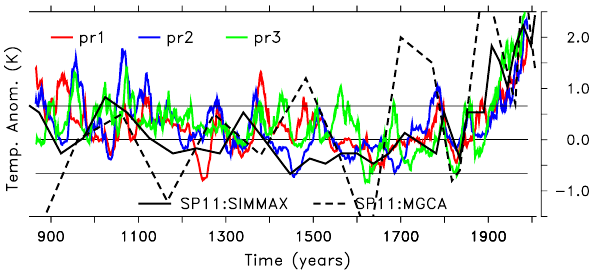
Figure 2. Simulated time series (coloured lines for experiments pr1, pr2, pr3) of Atlantic Water temperature anomalies w.r.t. the pre- industrial mean in Fram Strait (78 ◦ N, 50m depth) in comparison with the reconstruction by Spielhagen et al. (2011) obtained by the (solid black) SIMMAX and (dashed black) Mg / Ca methods. The thin horizontal lines bracketing the zero line indicate the respective 2 σ ranges derived from the 1000-year-long PiCtrl